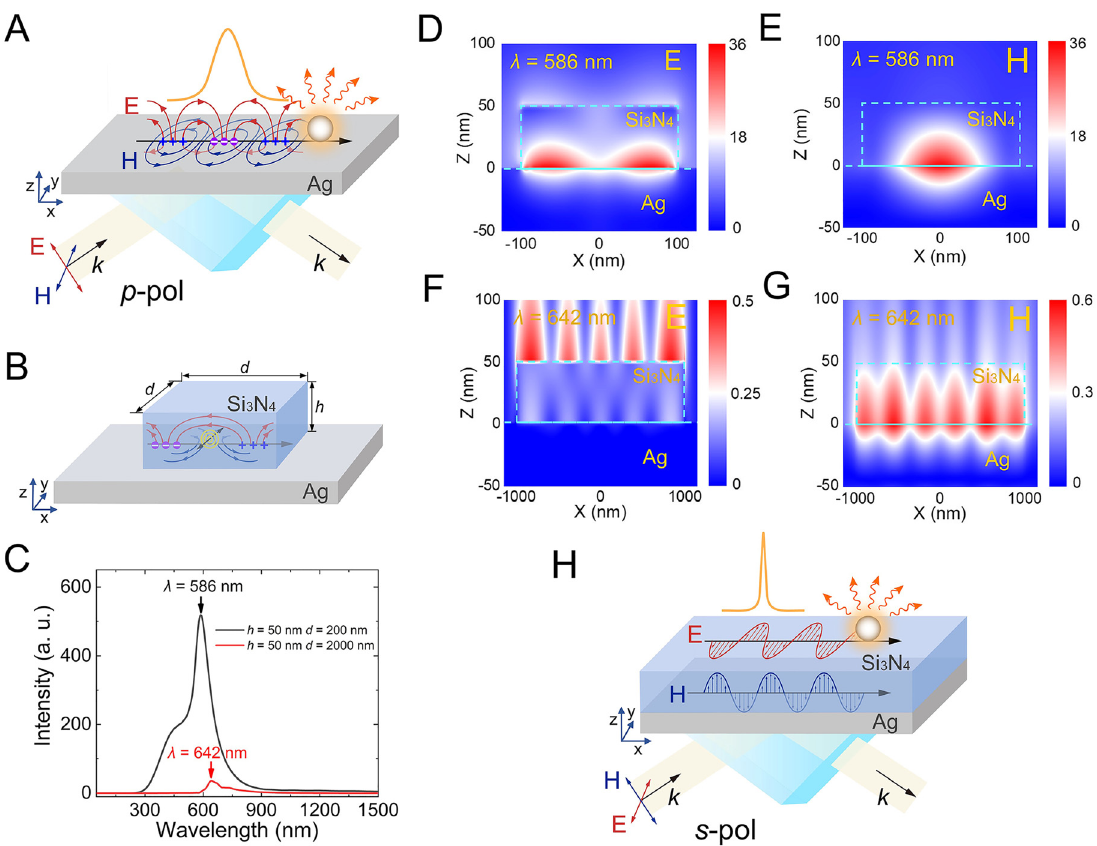
Figure 1: (A) Schematic showing the excitation of a TM wave (SPPs) on a bare metal surface by using p -polarized light. The TM wave can be scattered into free space by using a nanoparticle on the metal surface. (B) A Si 3 N 4 cuboid placed on an Ag fi lm. A horizontally oriented dipole source is used to excite the optical modes supported by the Si 3 N 4 cuboid. (C) Radiation spectra calculated for two Si 3 N 4 cuboids with d = 200 and 2000 nm, h = 50 nm, which are excited by the horizontally oriented dipole source. (D) and (E) Electric and magnetic fi eld distributions calculated for a Si 3 N 4 cuboid with d = 200 nm at λ = 584 nm. (F) and (G) Electric and magnetic fi eld distributions calculated for a Si 3 N 4 cuboid with d = 2000 nm at λ = 642 nm. (H) Excitation of a TE wave propagating in a dielectric-metal (Si 3 N 4 /Ag) heterostructure by using s -polarized light. The TE wave can be scattered into free space by using a nanoparticle on the metal